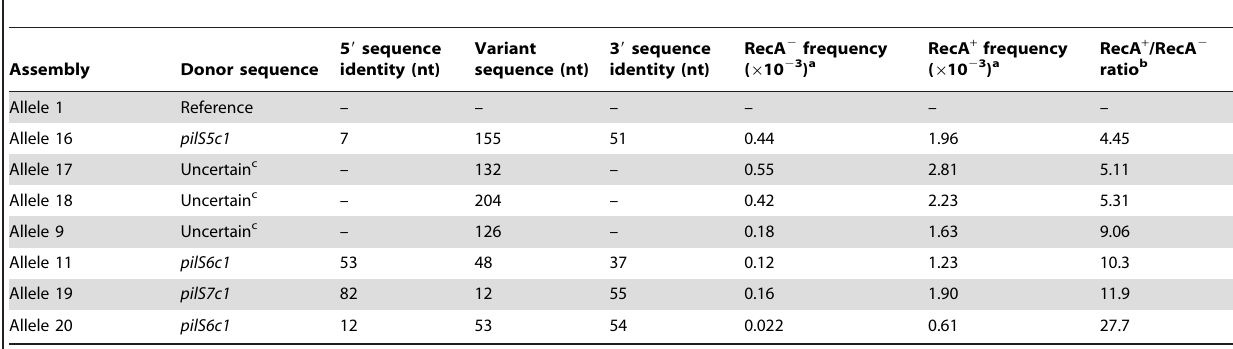
Table 6. Variant sequences detected in the repeat experiment with pilE from N. gonorrhoeae